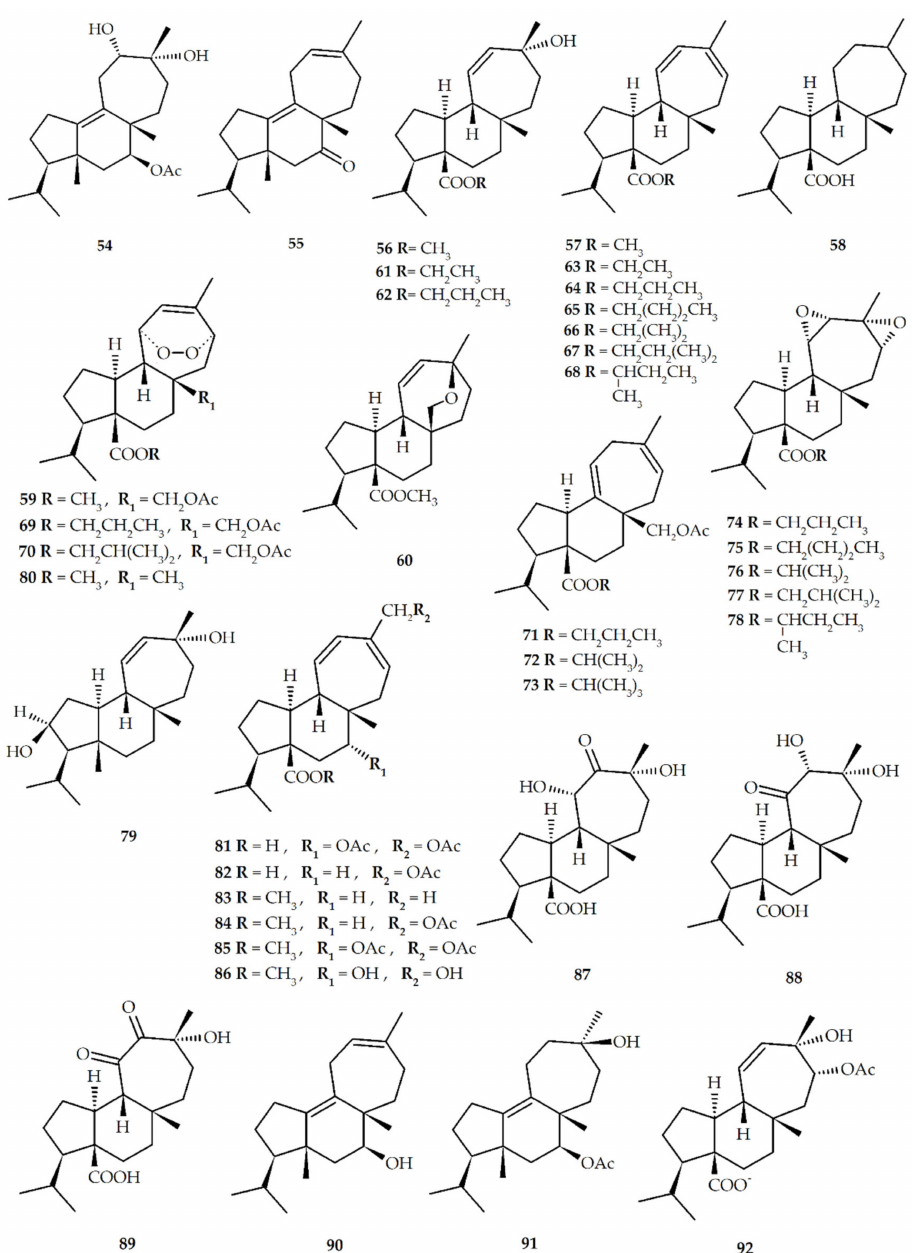
Figure 5. Semisynthetic mulinane